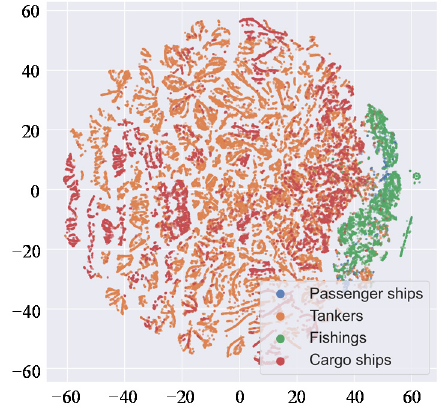
Figure 18. Visualization of static features.